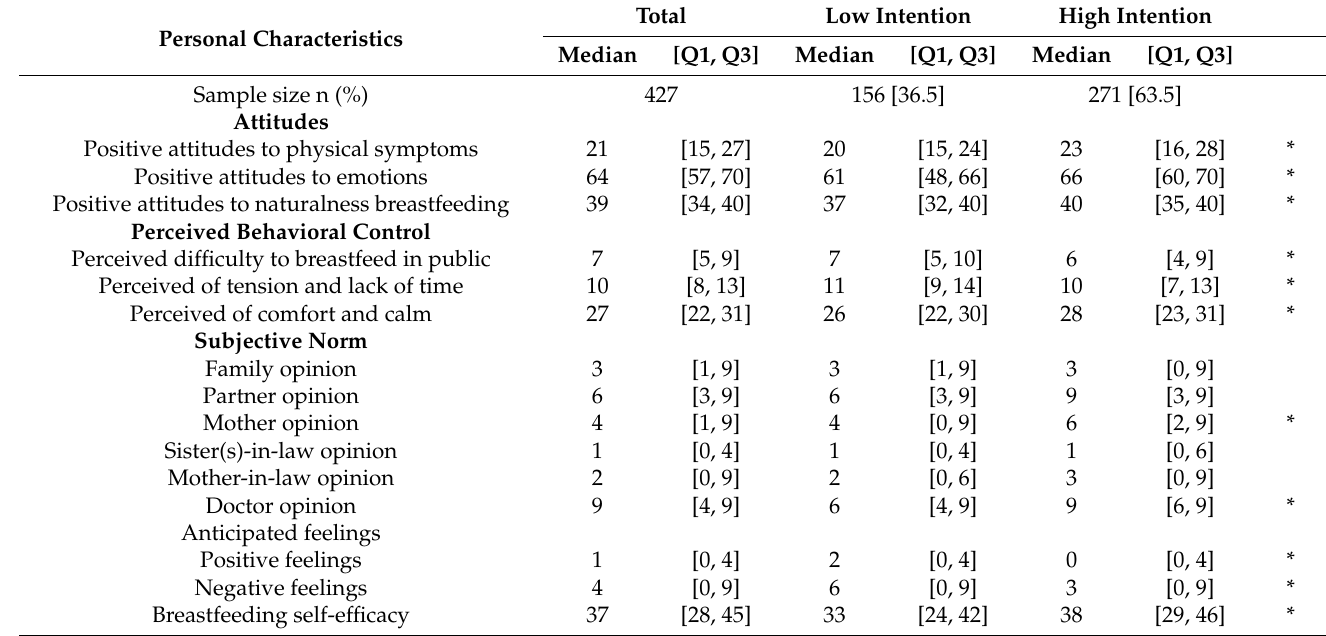
Table 3. Psychological variables by level of breastfeeding intention a .